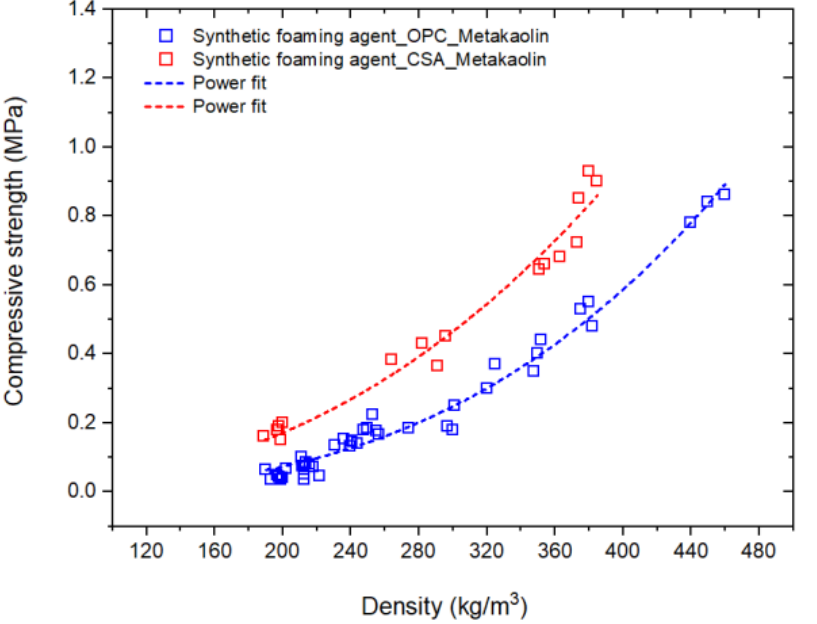
Figure 11. Compressive strength of foam concrete made of a synthetic foaming agent with OPC or CSA and metakaolin.